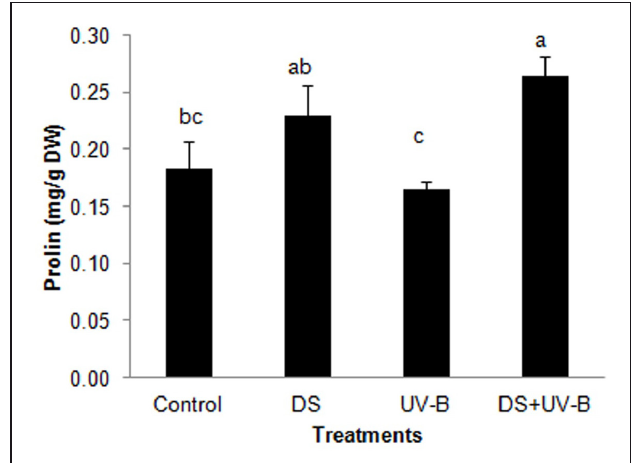
Fig. 4: Total phenolic content (mg GAE g -1 DM) of lettuce at harvest in response to drought stress, UV-B radiation and in combination of drought stress and UV-B radiation. Vertical bars represent standard deviation, and different letters indicate differences at the significance level p ≤ 0.05 (Tukey test). (Control = well-watered; DS = drought stress, i.e. water-deficit; UV-B = well-watered with UV-B radiation of 0.11 kJ m -2 ; DS+UV-B = drought stress i.e. water-deficit in combination with